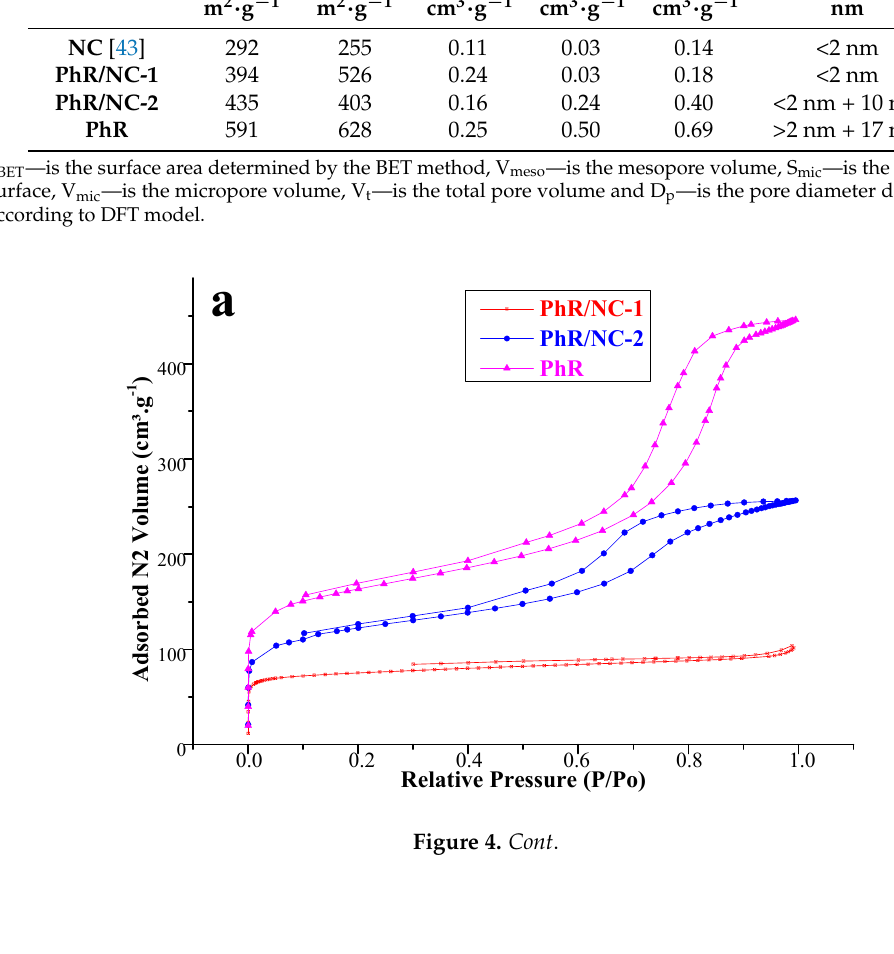
Unit Table 2. Textural characteristics of carbon materials determined from nitrogen sorption isotherms.